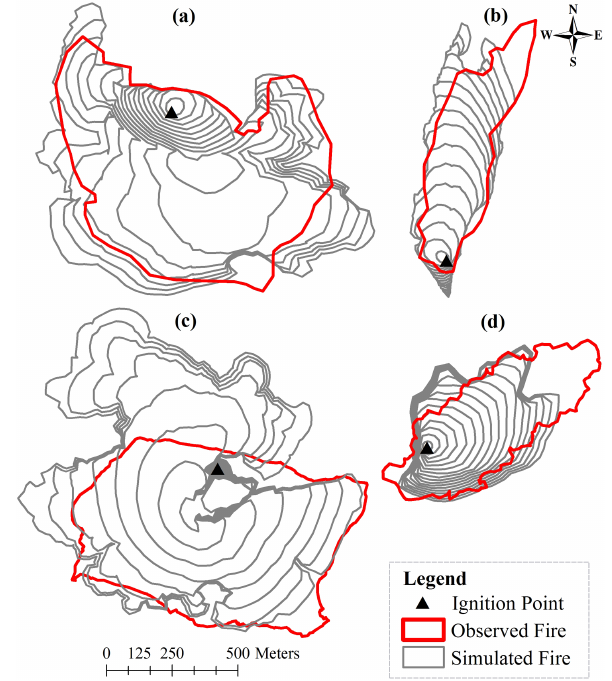
Figure 7. Fire spread perimeters (30m interval) of the best FAR- SITE simulations (grey; III for Toshi, II for Malekroud, VI for Yeke- Bermagh and I for Gharangi; Table 4) vs. observed fire perimeters (red): (a) Toshi, (b) Malekroud, (c) YekeBermagh, (d)